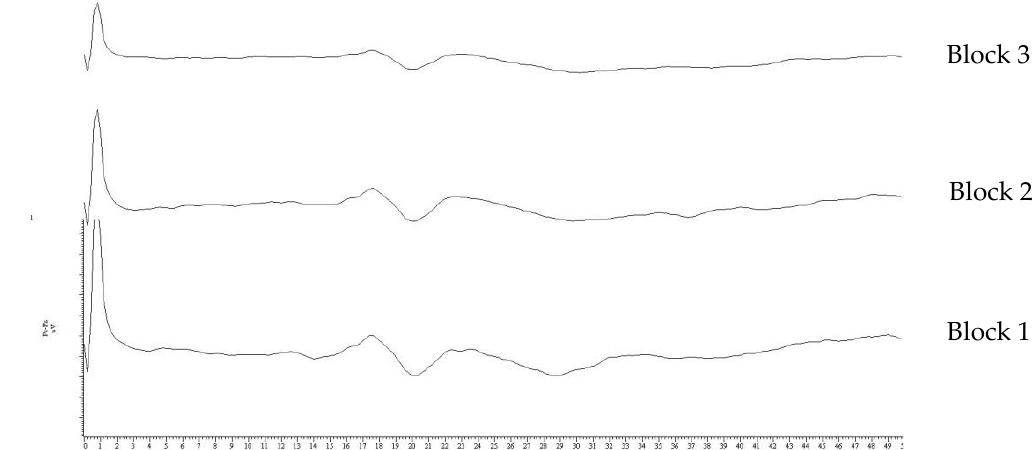
Figure 1. SEPs habituation from block 1 to block 3 in a representative patient with VD-type cognitive disorder. Top row grand average of trials 1-200 (block 1), mid row grand average of trials 201-400 (block 2), bottom row grand average of trials 401-600 (block 3)